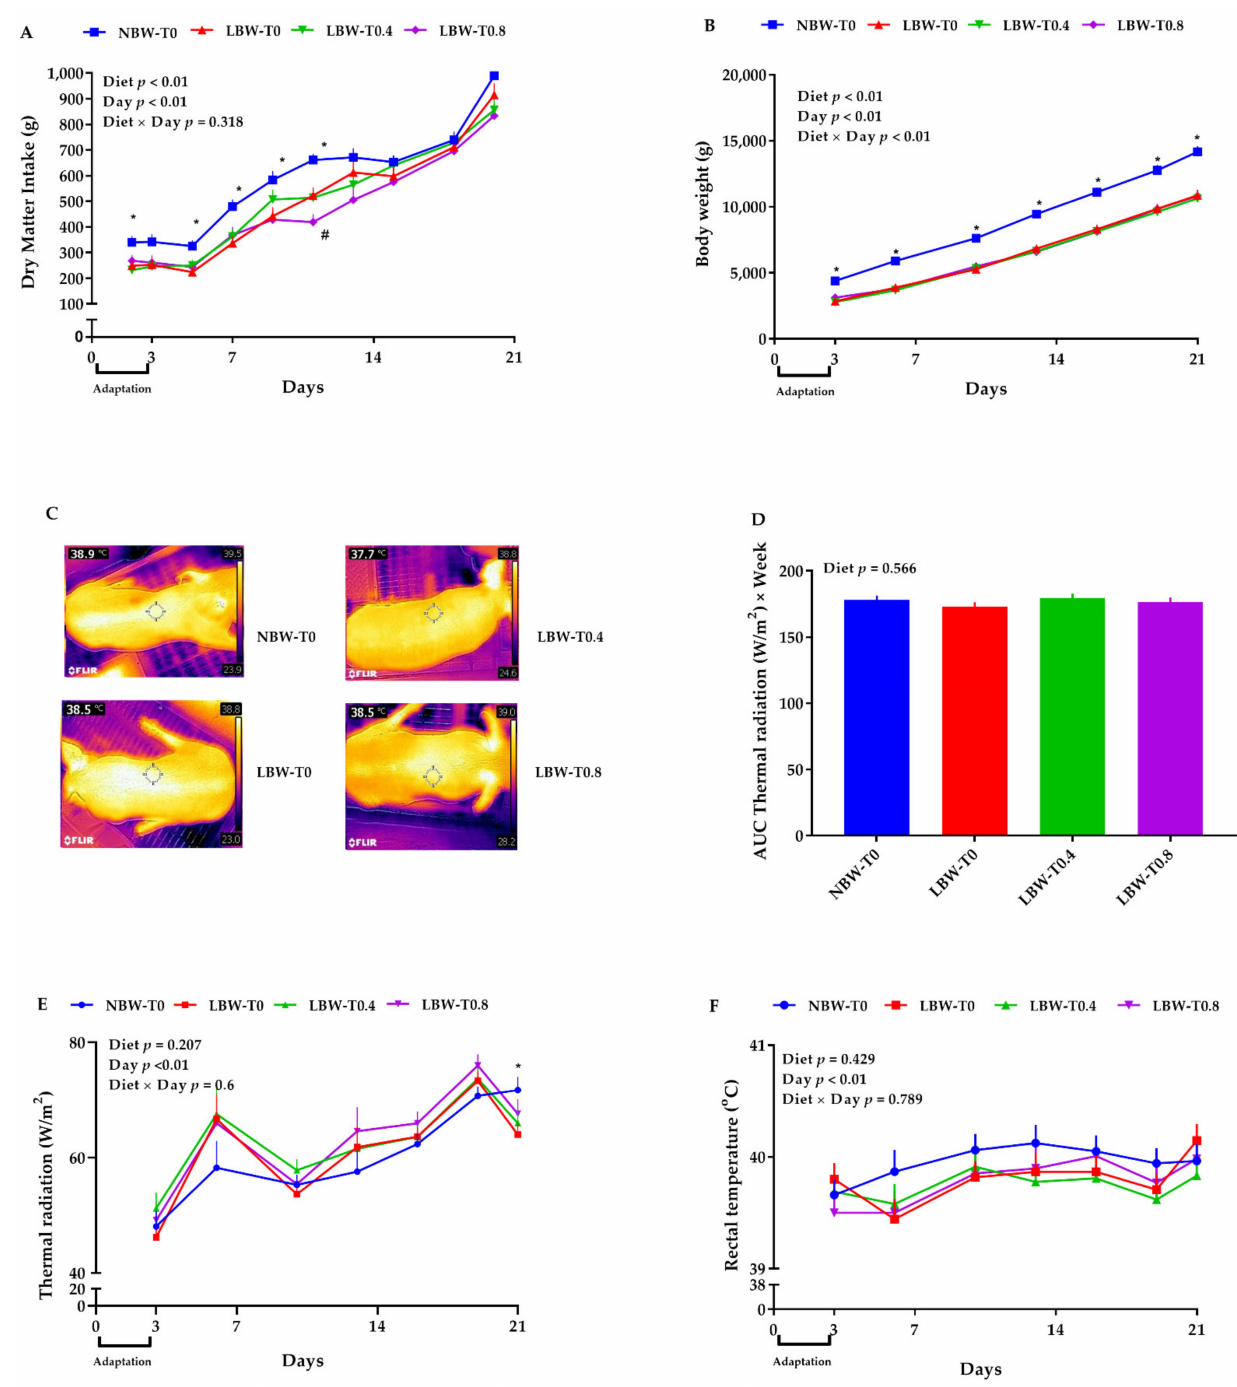
Figure 2. Effect of dietary L-tryptophan supplementation on dry matter intake, body weight, thermal radiation, and area un- der the curve (AUC) for the thermal radiation and rectal temperature of low-birthweight neonatal pigs. ( A ) dry matter intake, ( B ) body weight, ( C ) representative thermal images, ( D ) area under the curve (AUC) thermal radiation, ( E ) thermal radiation, and ( F ) rectal temperature. NBW-T0, normal-birthweight piglets fed a basal diet without supplemented L-tryptophan (Trp); LBW-T0, low-birthweight piglets fed a basal diet without supplemented Trp; LBW-T0.4, low-birthweight piglets fed a diet supplemented with 0.4% Trp; and LBW-T0.8, low-birthweight piglets fed a diet supplemented with 0.8% Trp. n = 8 for NBW-T0, LBW-T0, and LBW-T0.8, and n = 7 for LBW-T0.4. * p ≤ 0.05 vs. LBW-T0; # 0.05 < p ≤ 0.1 vs. LBW-T0. The values are the means ±